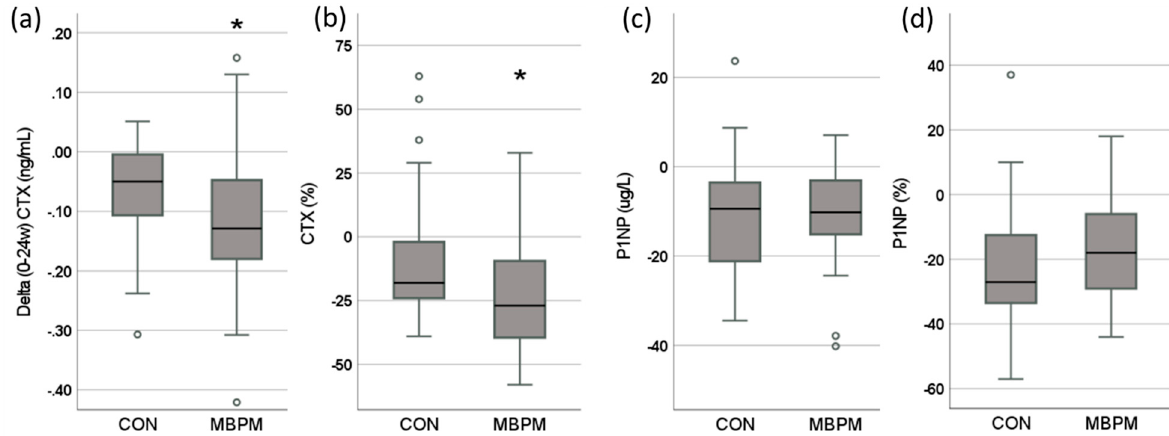
Figure 3. Absolute and relative change, from 0 to 24 weeks, in the homeostatic level of a biomarker of bone resorption (CTX; ( a , b )) and bone formation (P1NP: ( c , d )) following 24-week ingestion of CON and MBPM. * Denotes significant difference between CON and MBPM, p < 0.05.